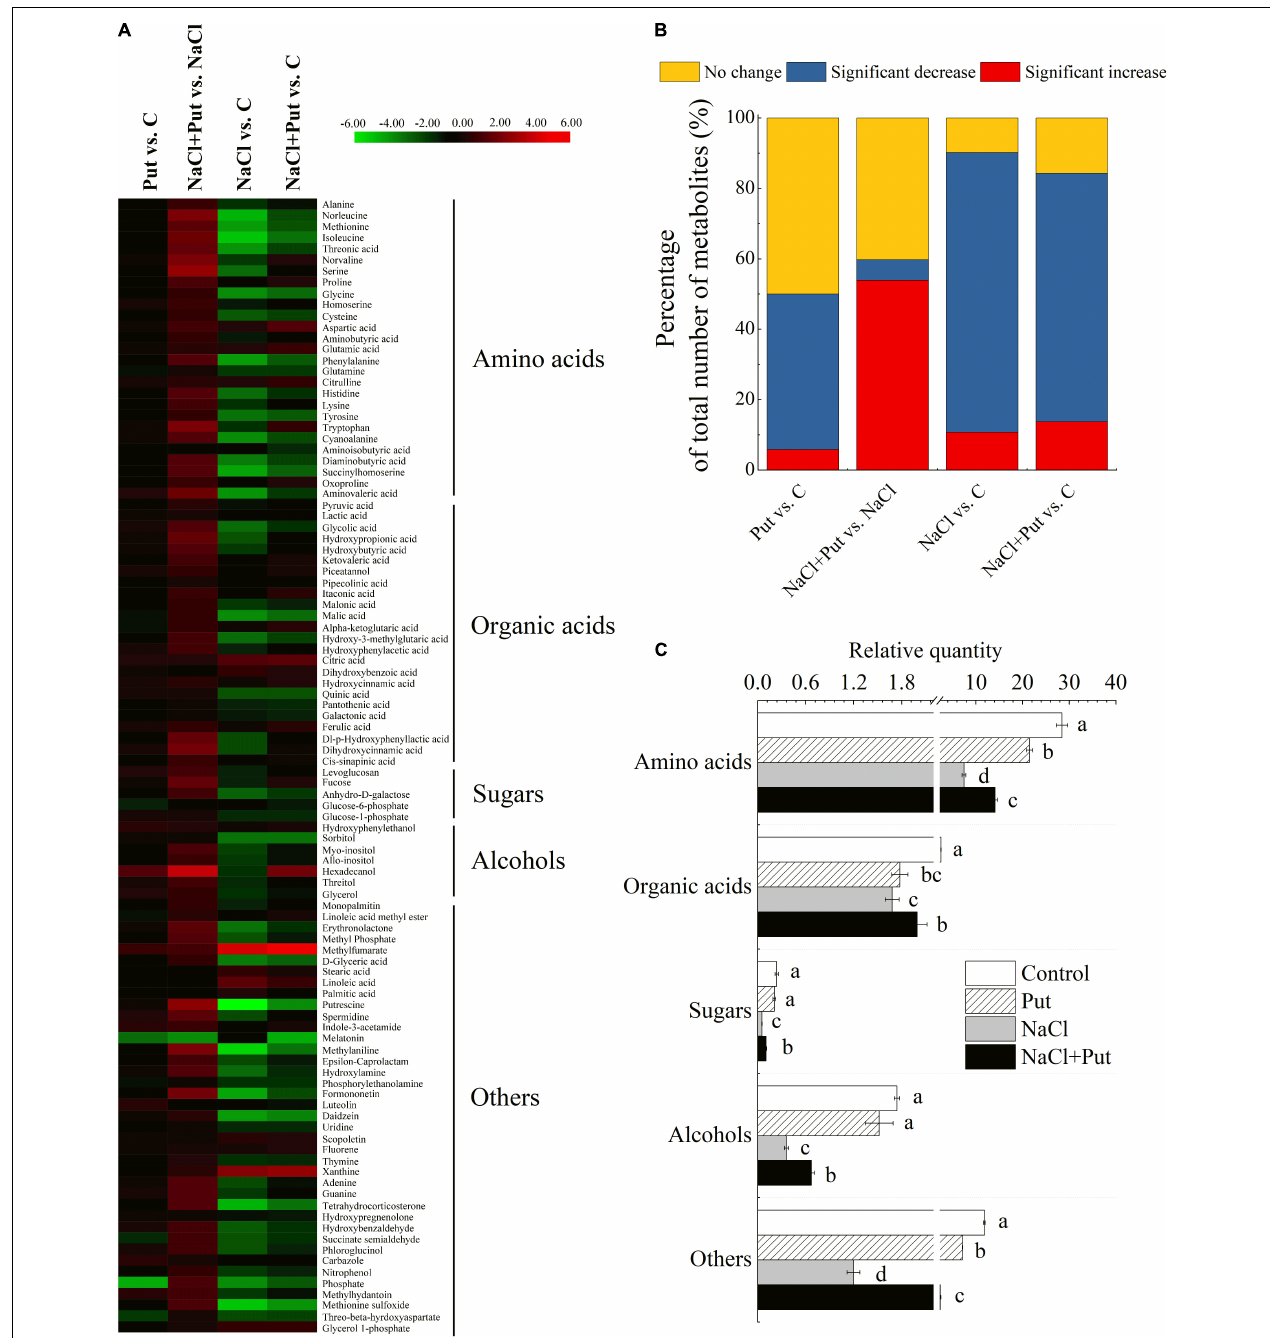
FIGURE 5 | Effects of seed soaking with Put or water on (A) heat map of changes in 102 metabolites, (B) percentage of the total number of metabolites in each group, and (C) total content of AAs, organic acids, sugars, alcohols, and others in each treatment in white clover seedlings after 7 d of germination in response to exogenous Put application and salt stress. Log 2 (fold change) ratios were shown in the heat map. Red and green indicate the up—and down—regulation, respectively. Vertical bars above columns indicate the standard error of each mean ( n = 4). Different letters indicate a significant difference. LSD ( P ≤